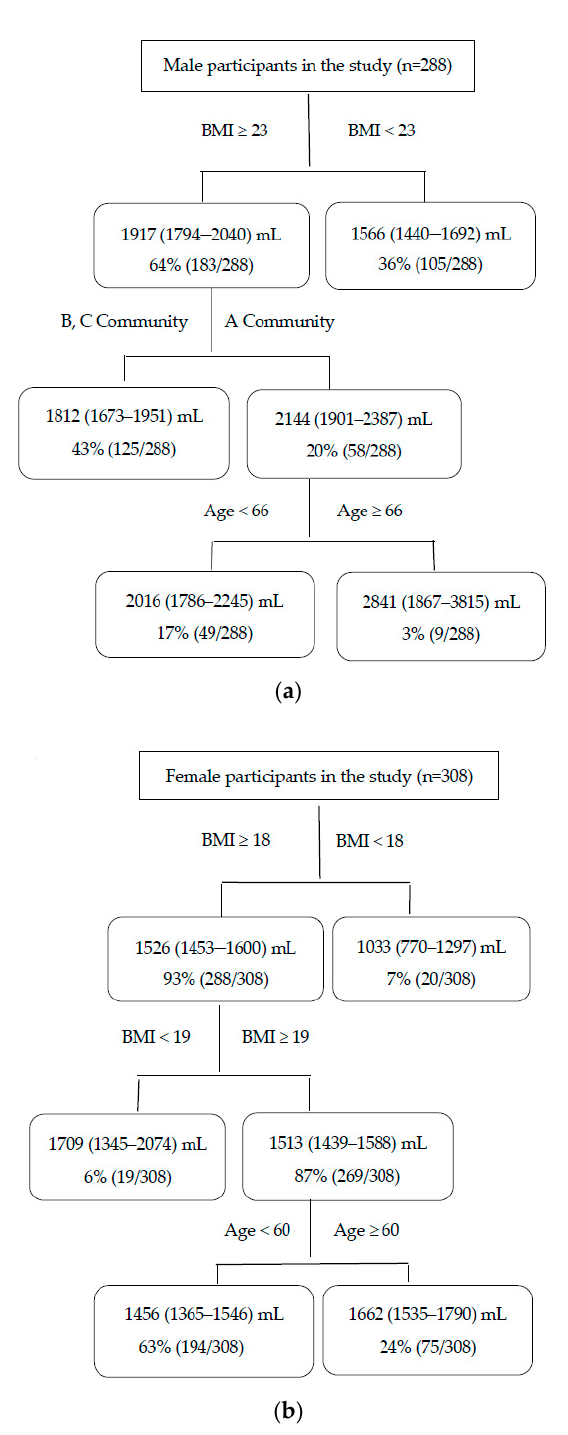
Figure 2. Impacts of age, BMI, and location on daily water consumption among the adults in summer according to CART analysis in the study (age: years, BMI: kg/m 2 ). The figures in the rectangle indicate the mean (95% CI) values of daily water consumption and the probability; a: male, b: female.